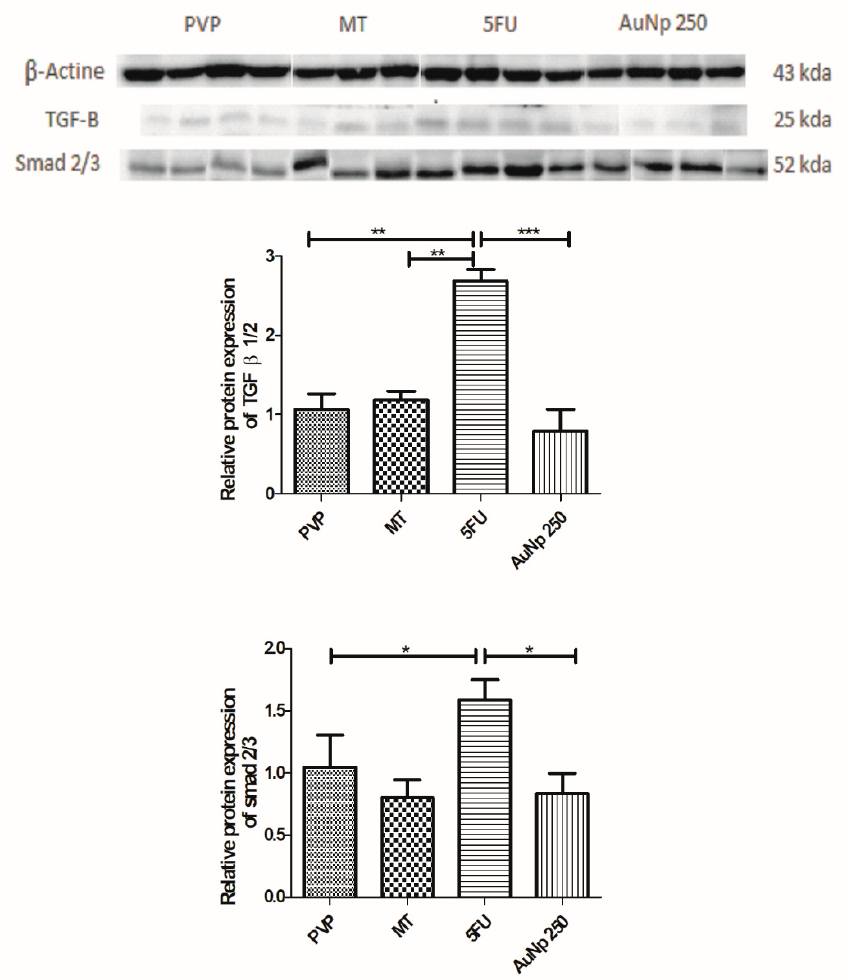
Figure 6. Representative images of TGF- β and SMAD 2/3 immunoblotting. The PVP group: Animals without OM. The mechanical trauma (MT) group: Hamsters that were subjected to mechanical trauma. The 5-FU group: Animals received 5-FU and were subjected to MT. The AuNp groups received 5-FU, were subjected to MT, and received AuNp at one of three doses (62.5, 125, or 250 µ g / kg). The bands were visualized with an ECL system (BioRad). Lower expression of TGF- β or SMAD 2 / 3 was observed in the animals treated with AuNp 250 µ g / kg as compared to the animals of group 5-FU. The chemiluminescence signal was detected with a ChemiDocTM XRS system (BioRad) and densitometrically quantified in ImageJ software (NIH, Bethesda, MD). The results are presented as the mean ± standard error of the mean, ( n = 5 / group). * p < 0.05; ** p < 0.001; *** p < 0.0001 (Analysis of variance followed by Tukey’s post-test.).